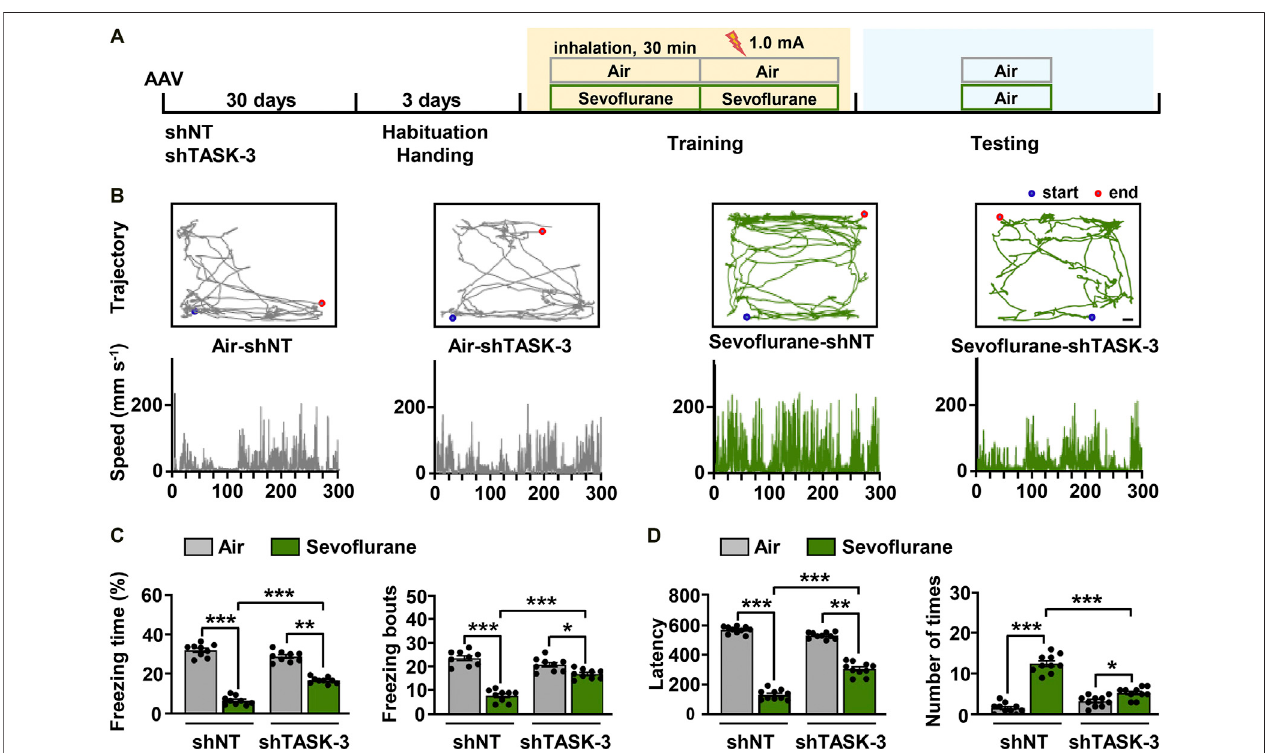
FIGURE 5 | TASK-3 channels mediate sevo fl urane-induced memory impairment. (A) Timeline of experiment. After adeno-associated virus (AAV) injection for 1 month, mice were fear-conditioned to test their memory performance. (B) Locomotor trajectory and corresponding moving speeds of representative mice in four different experimental groups throughout an entire (5 min) testing session. Scale bar, 4.17 cm. (C) Bar graphs show the percentage of freezing time and number of freezing bouts for the control and TASK-3knockdown mice when re-exposed tothe conditioning context. N (cid:2) 9/group. (D) The time taken before the trained mice again crossed intothe shock compartment (left) and thenumber oftimes mice entered theshock compartment (right) . N (cid:2) 10/group. Values are shown asthemean ± SEM. * p < 0.05, ** p < 0.01, *** p <